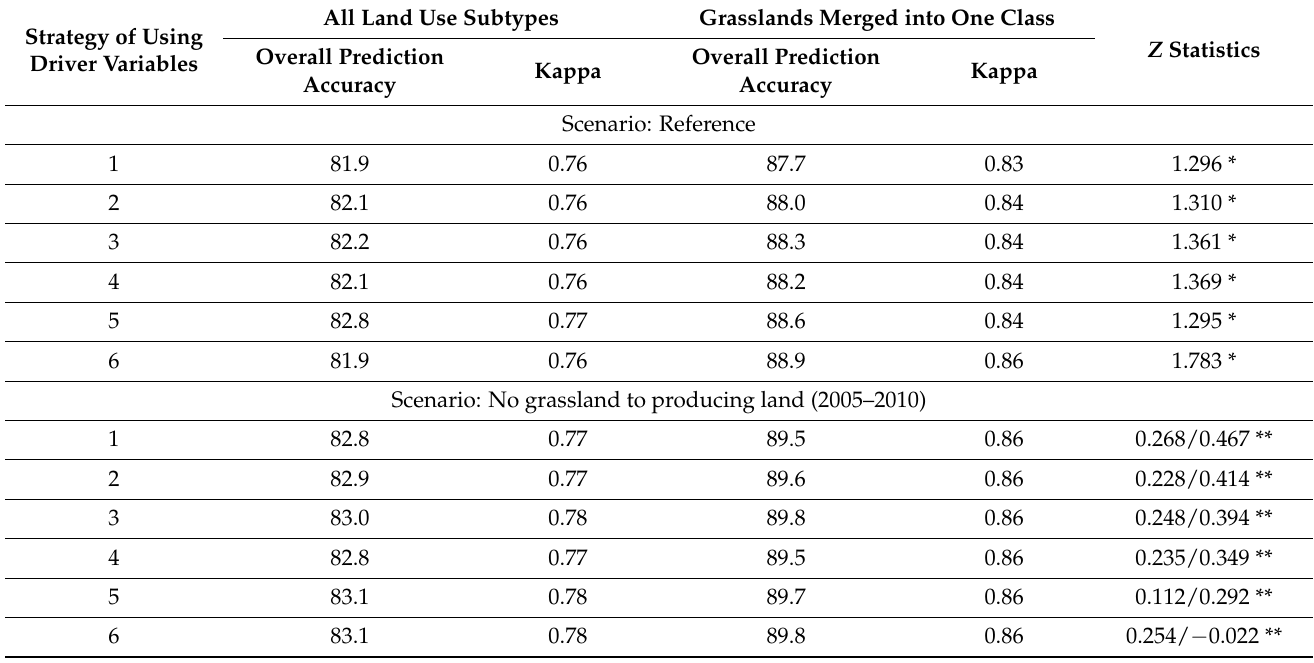
Table 3. Prediction accuracy of all tested land use